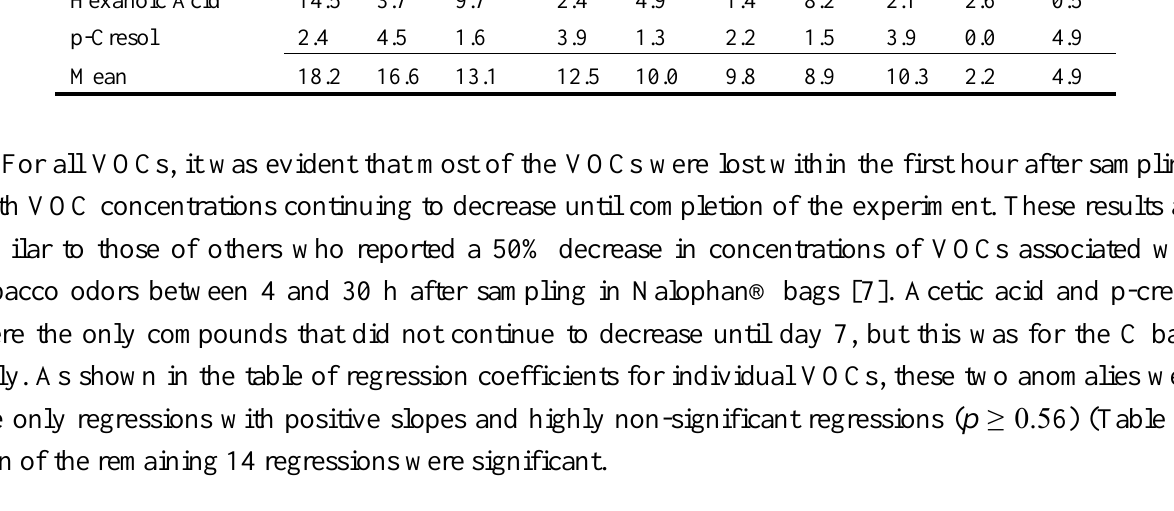
Table 4. Regression coefficients for the individual VOC recoveries of Table 3, using